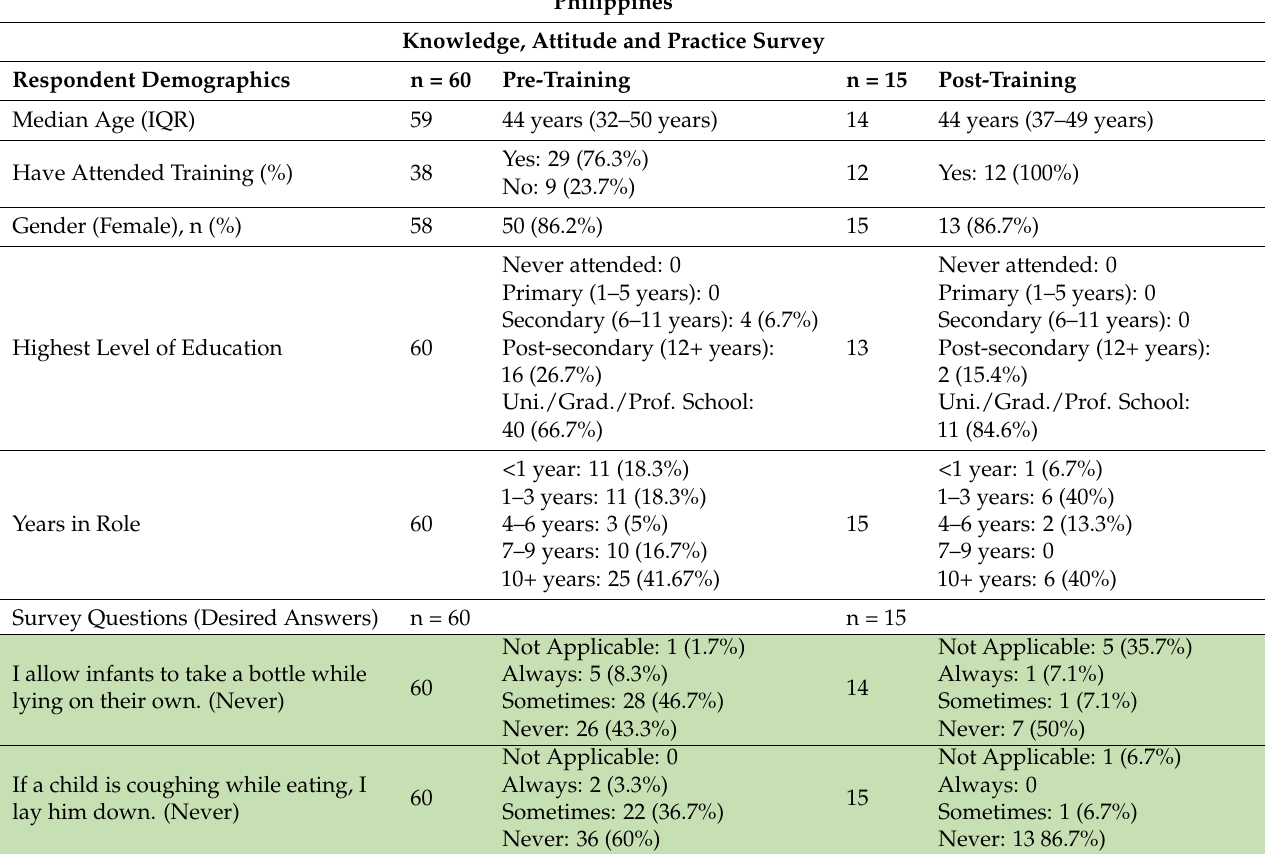
Table A2. Prevalence of Desired Answers of Knowledge, Attitude and Practice Surveys (KAPS) from Pre-training and Post-training in the Philippines. Knowledge Questions are Yellow, Attitude Questions Red and Practice Questions